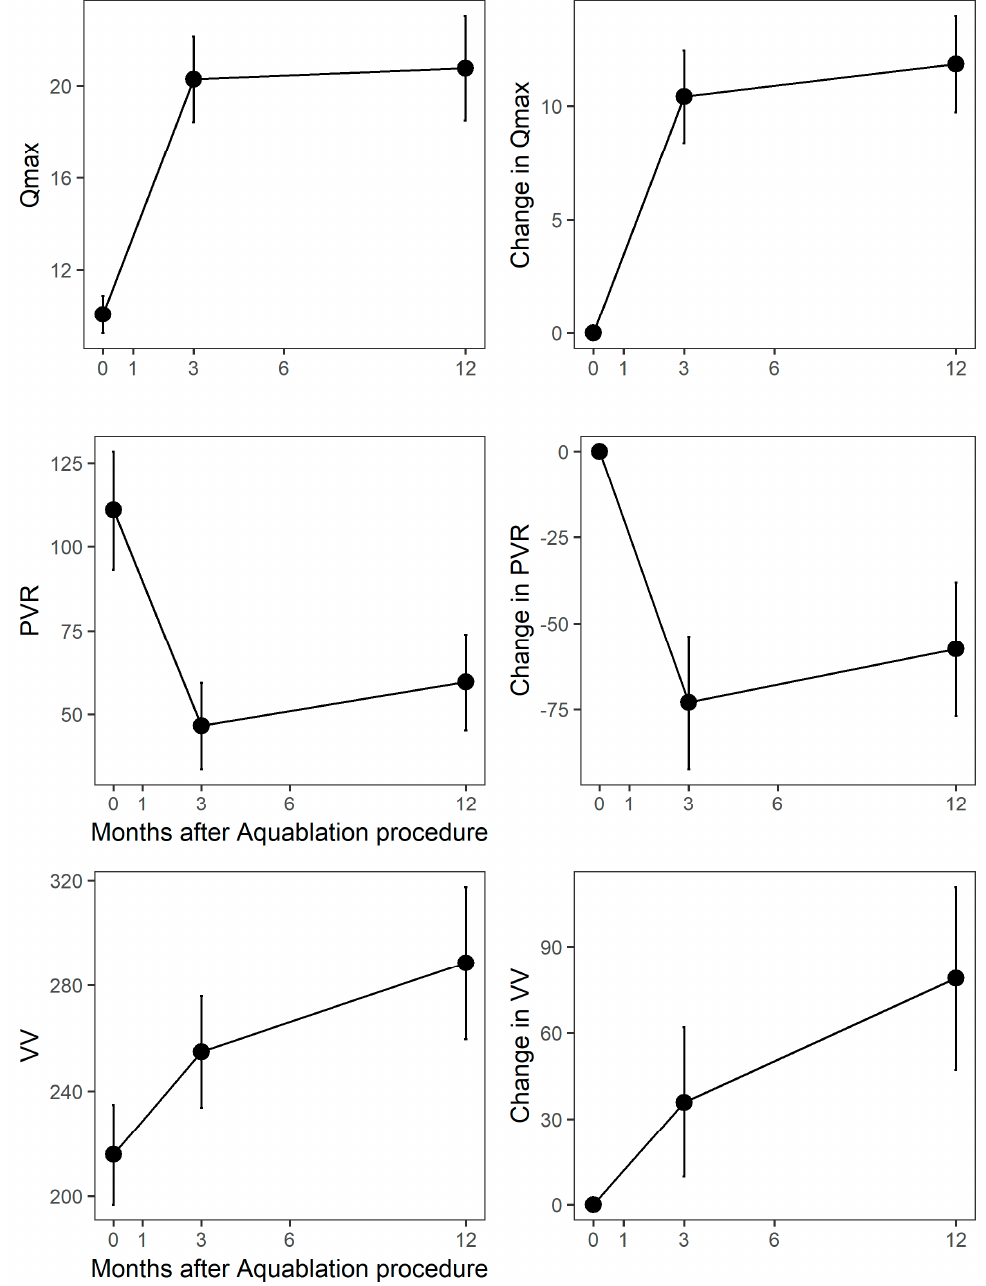
Figure 2. Absolute (y-axis) and change (y-axis) in uroflow parameters after Aquablation. Qmax = maximal urinary flow rate; PVR = post-void residual; VV = voiding volume. Population means are shown at the left; change from the baseline is shown at the right. Months after Aquablation procedure is the y-axis in all graphs.